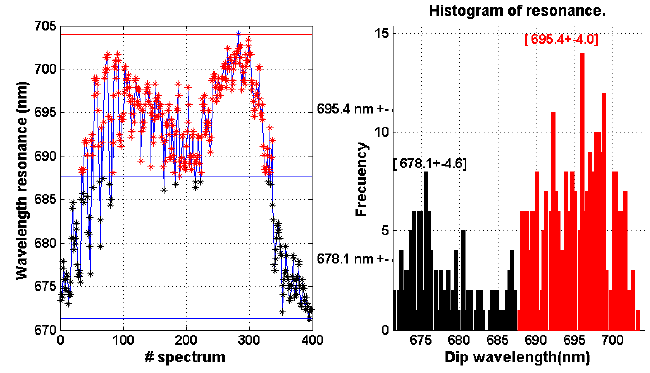
Figure 4. Left: Resonance wavelength along the zigzag scanning. Right: Histogram of the resonance wavelength for the measurement of Figure 3. The values marked in red correspond to the inner locations of the sensor while the black ones correspond to the periphery.